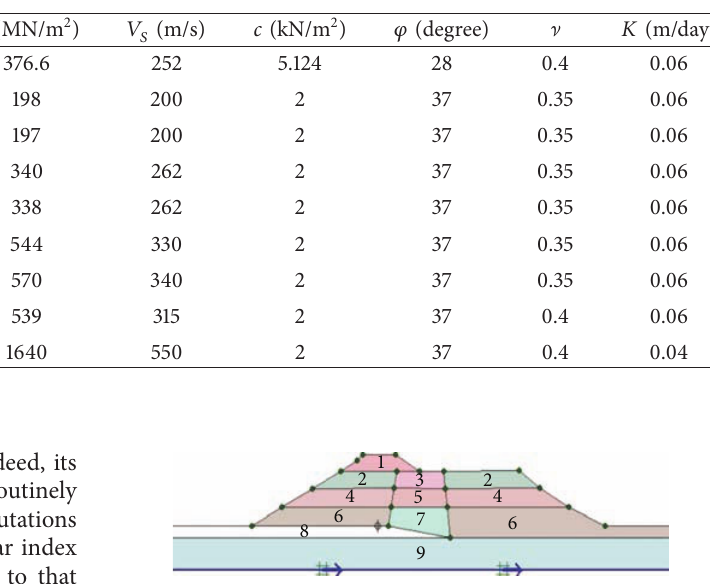
shown in Figure 1, the dam is divided into 9 different layers, each representing a different soil material zone. These soil units of dam section have been classified using (1) suggested by Sawada and Takahashi [9]. The equation indicates the effect of height variation on the shear wave velocity and shear modulus of the layers materials located at different levels of the dam section.